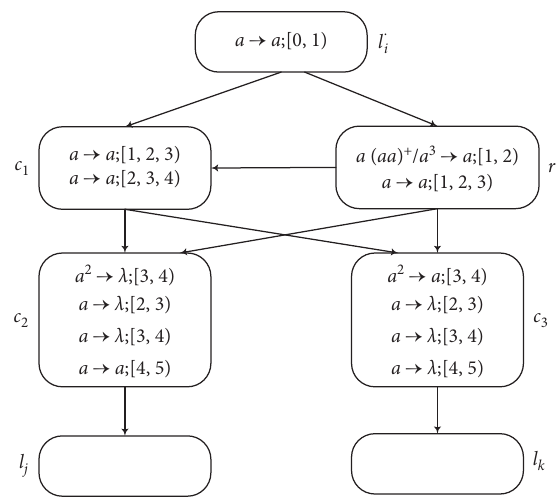
Figure 3: Module SUB: simulating the SUB instruction l